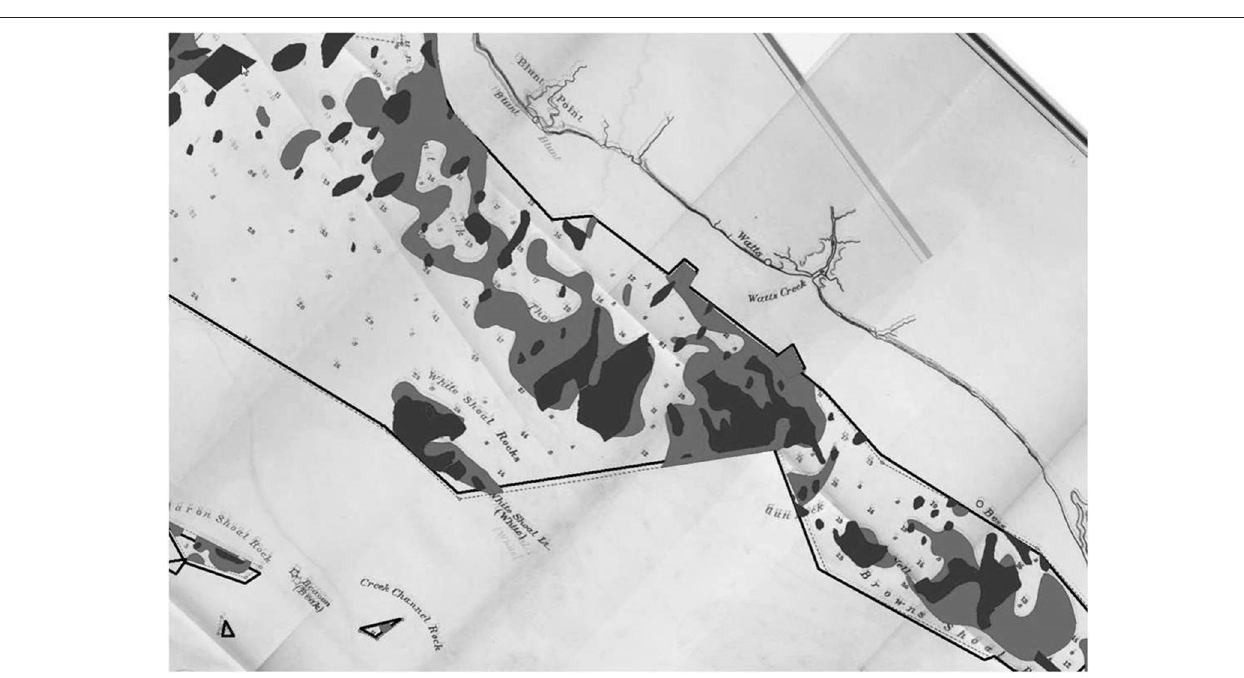
FIGURE 10 | Habitat loss between Moore Survey (1910, gray areas) and Haven et al. Survey (1981, black areas) in the James